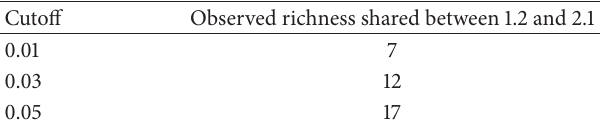
Table 3: OTUs shared between site 1.2 and 2.1 calculated with MOTHUR